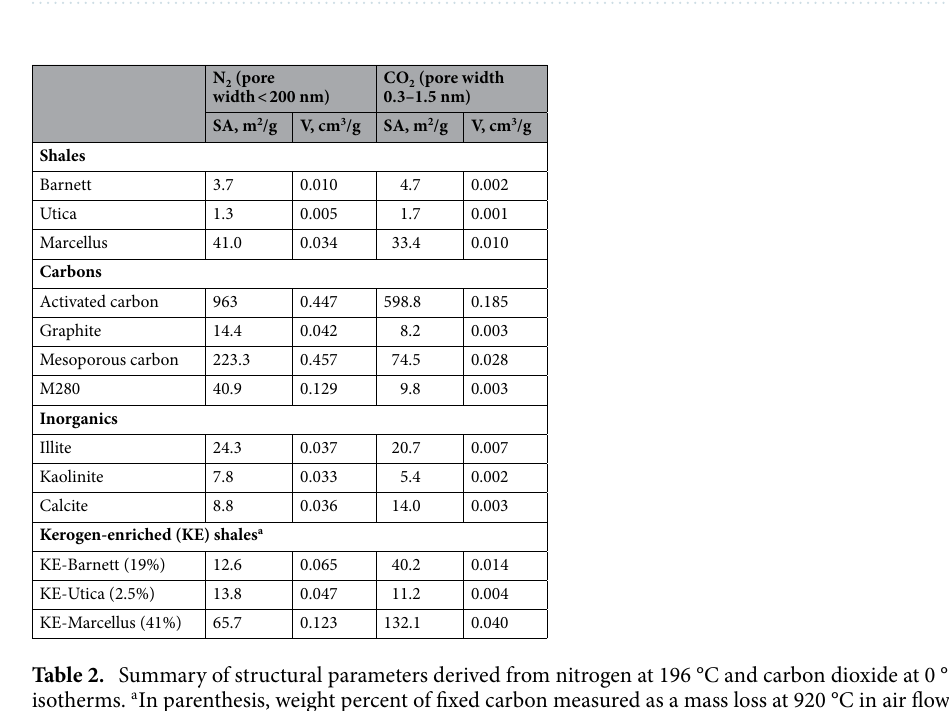
Table 1. Shale total organic content (TOC, wt%), thermal maturity (T max ,°C) and mineral composition (area%).